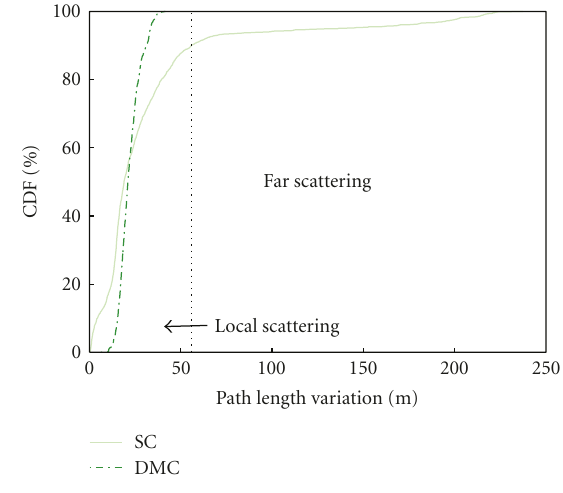
Figure 8: CDF of the path length